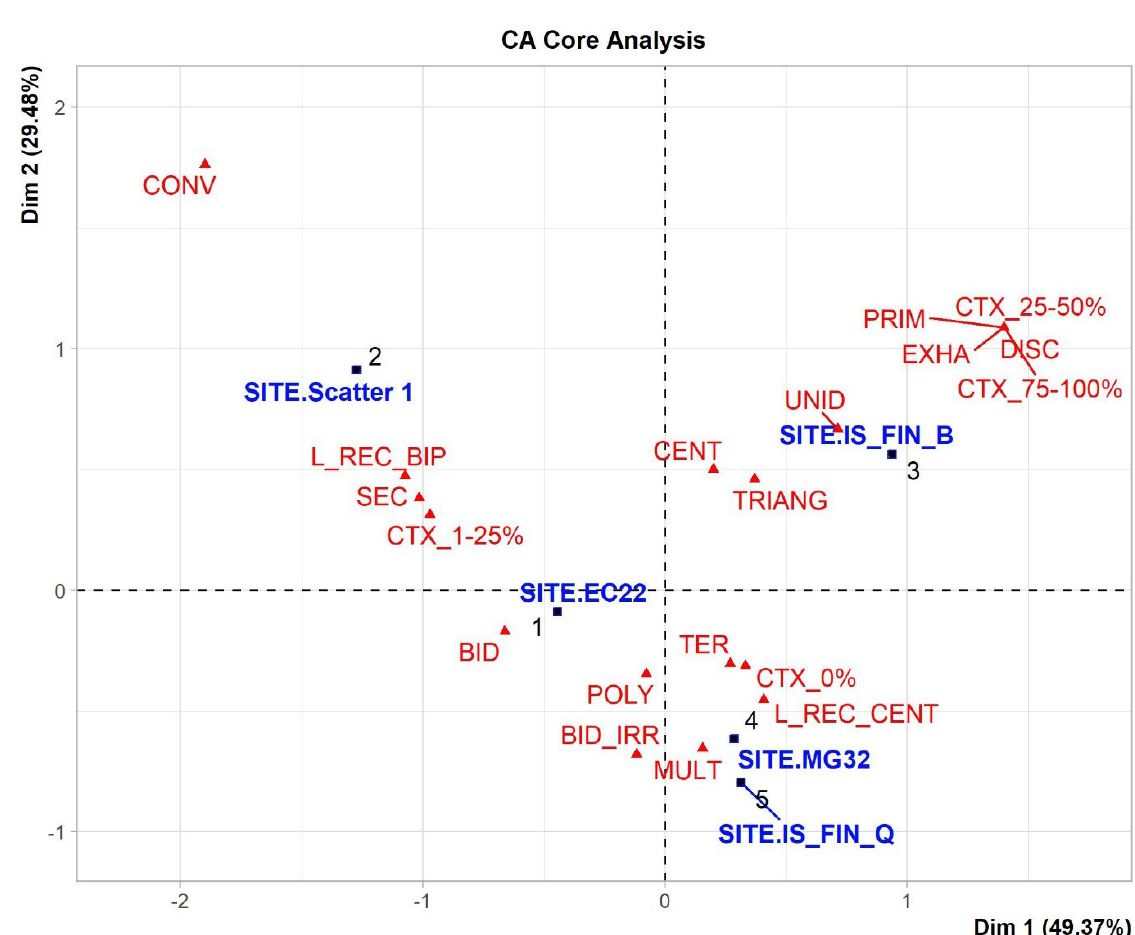
Figure 15: Correspondence analysis of cores. Supplementary variables are marked in blue while active variables are marked in